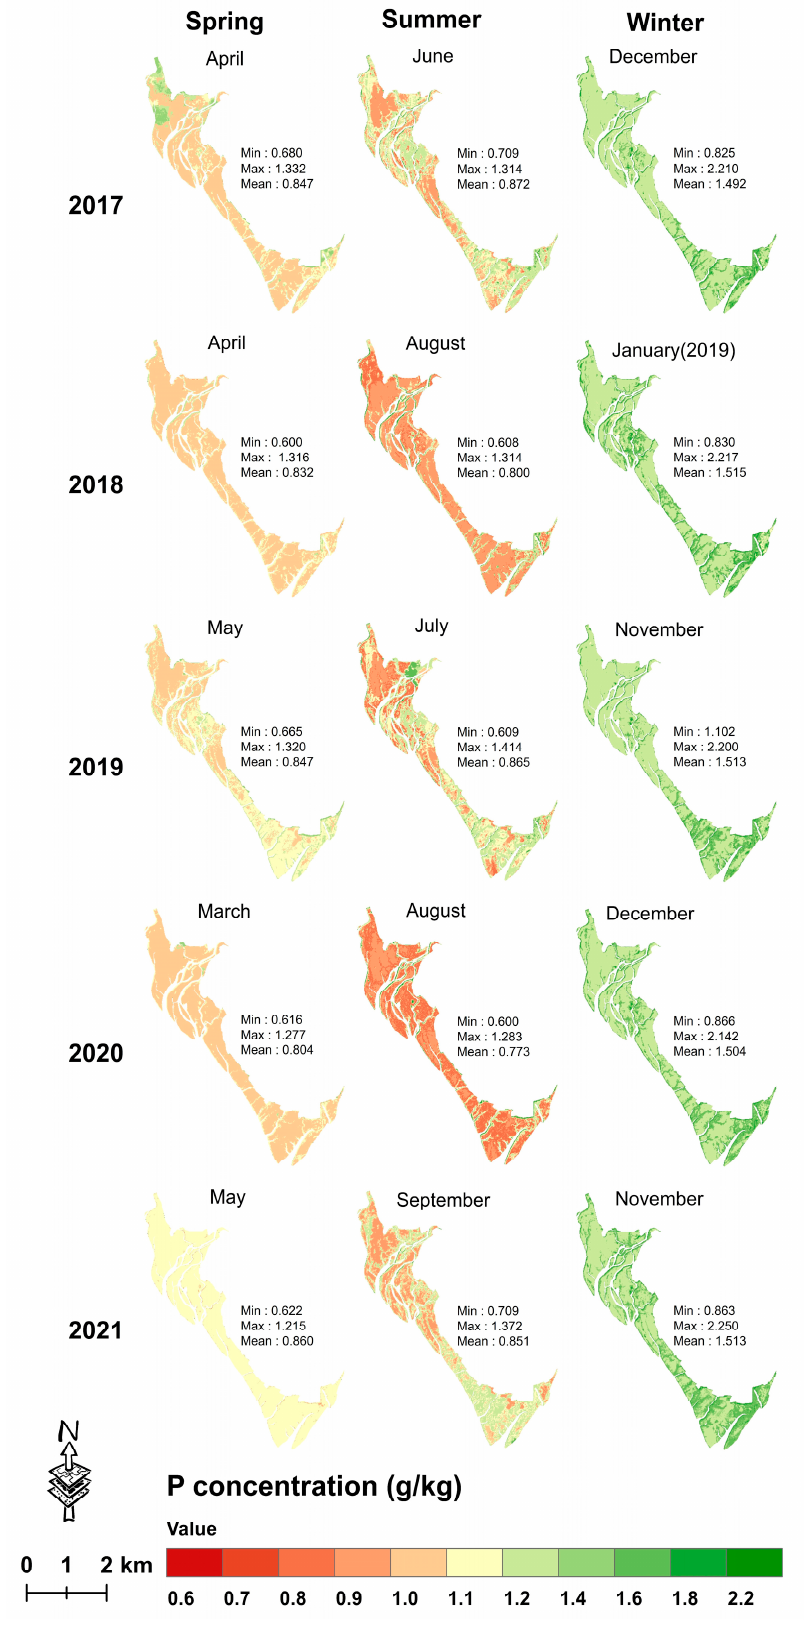
Figure 10. Seasonal leaf P mapping from 2017 to 2021 using the XGBoost model with the dataset of a single